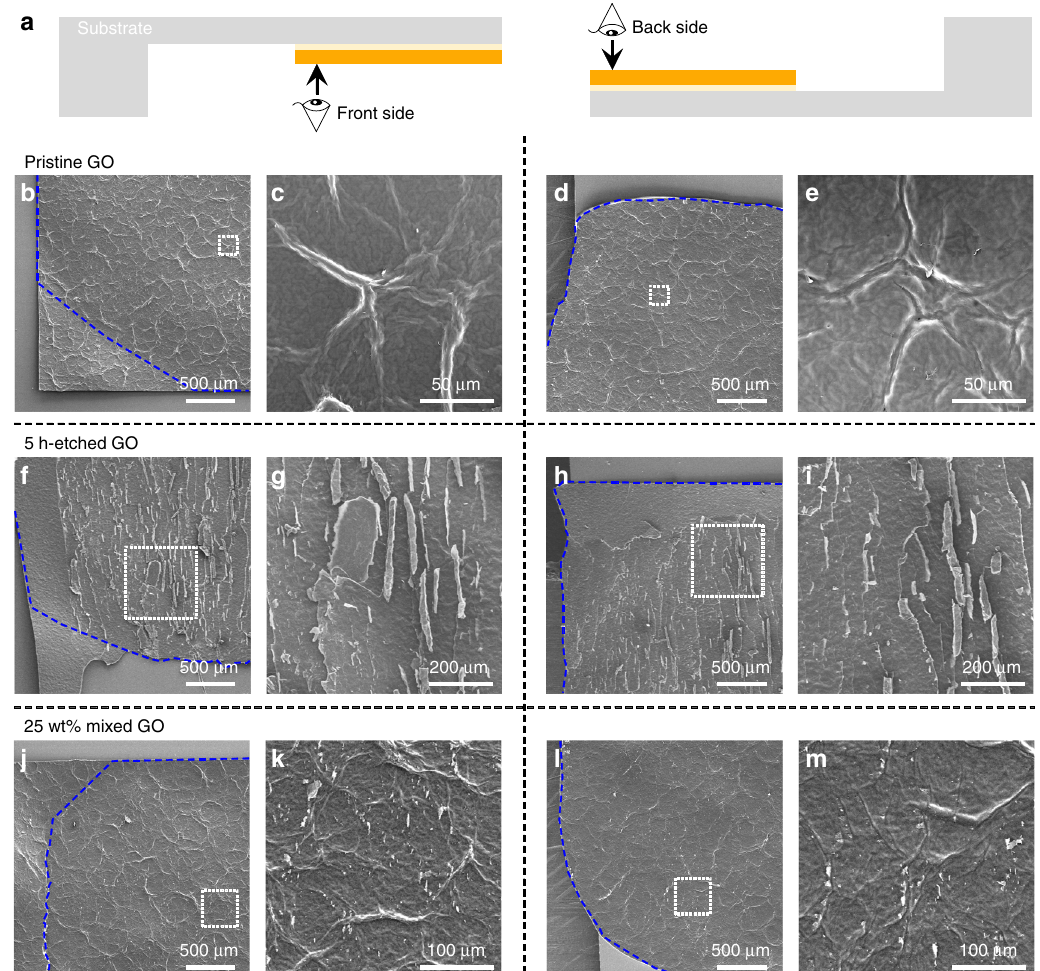
Fig. 6 SEM fractographic study after delamination. a Schematic drawing illustrating a GO fi lm delaminated after lap-shear test, which generate two fractured surfaces denoted as front and back sides. For the fi lms made from pristine, un-etched GO sheets, SEM images reveal b , c cellular patterns of “ upward ” wrinkles on one side of the delaminated surface, and d , e complementary “ downward ” wrinkles on the other side. For the fi lms made from 5-h- etched porous GO sheets, f – i both sides have terrace-like structure with some fl akes being nearly pulled out. For the fi lms made from a mixture of pristine and 25 wt% of 5-h-etched porous GO sheets, j – m the fractured surfaces show both wrinkles and terraces. The blue dashed lines in the low-magni fi cation images ( b , d , f , h , j , l ) indicate the area of epoxy adhesive behind the delaminated GO. The higher-magni fi cation images ( c , e , g , i , k , m ) are taken in the areas indicated by the white boxes in the corresponding low-magni fi cation